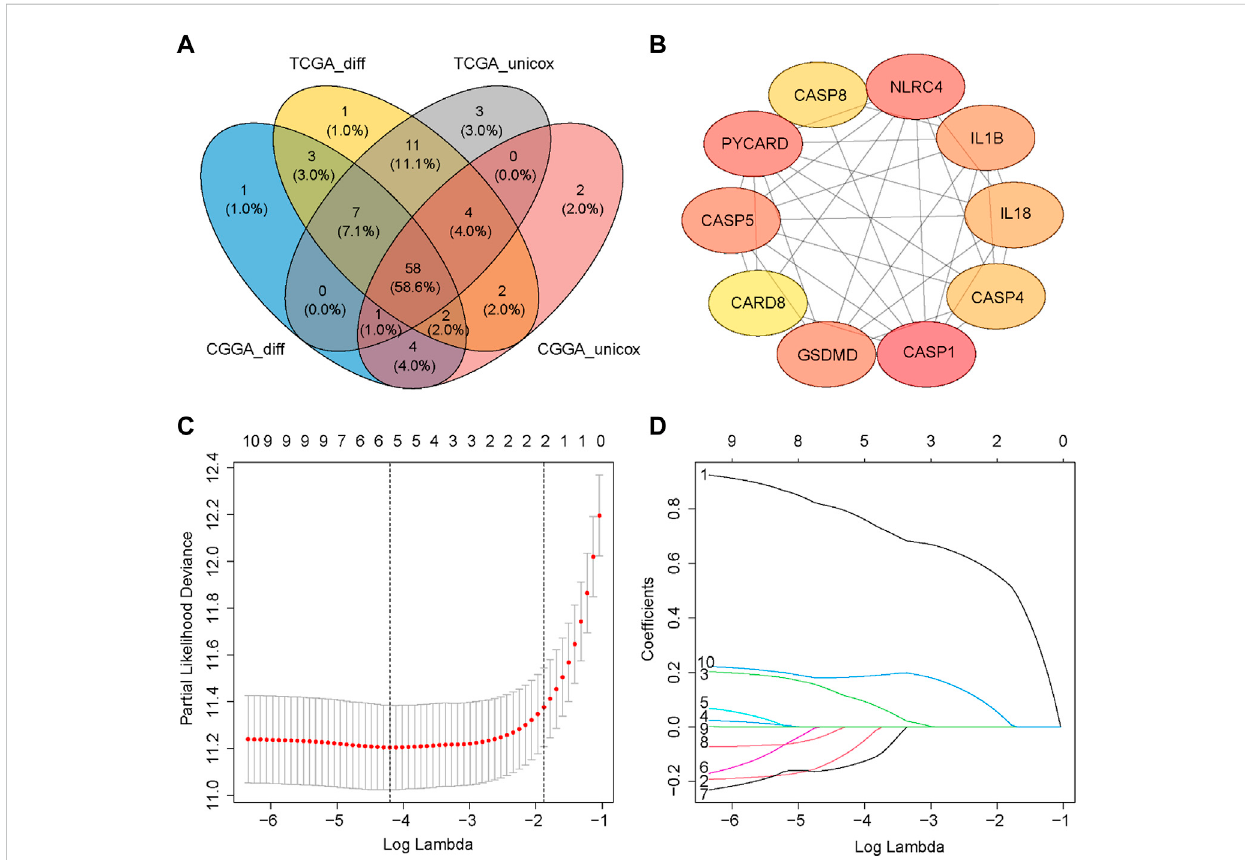
FIGURE 3 Identi fi cation of prognosticDEGs and construction of thePRGs signature. (A) Wayne Diagram shows the result ofthe intersection of four gene sets. (B) PPI network of the top 10 hub nodes. (C) Selection of the penalty parameter ( λ ) in the LASSO model via ten-foldcross-validation. The dotted vertical lines are plotted at the optimal values following the minimum criteria (left) and “ one standard error ” criteria (right). (D) LASSO coef fi cient pro fi les of the expression of ten candidate genes.